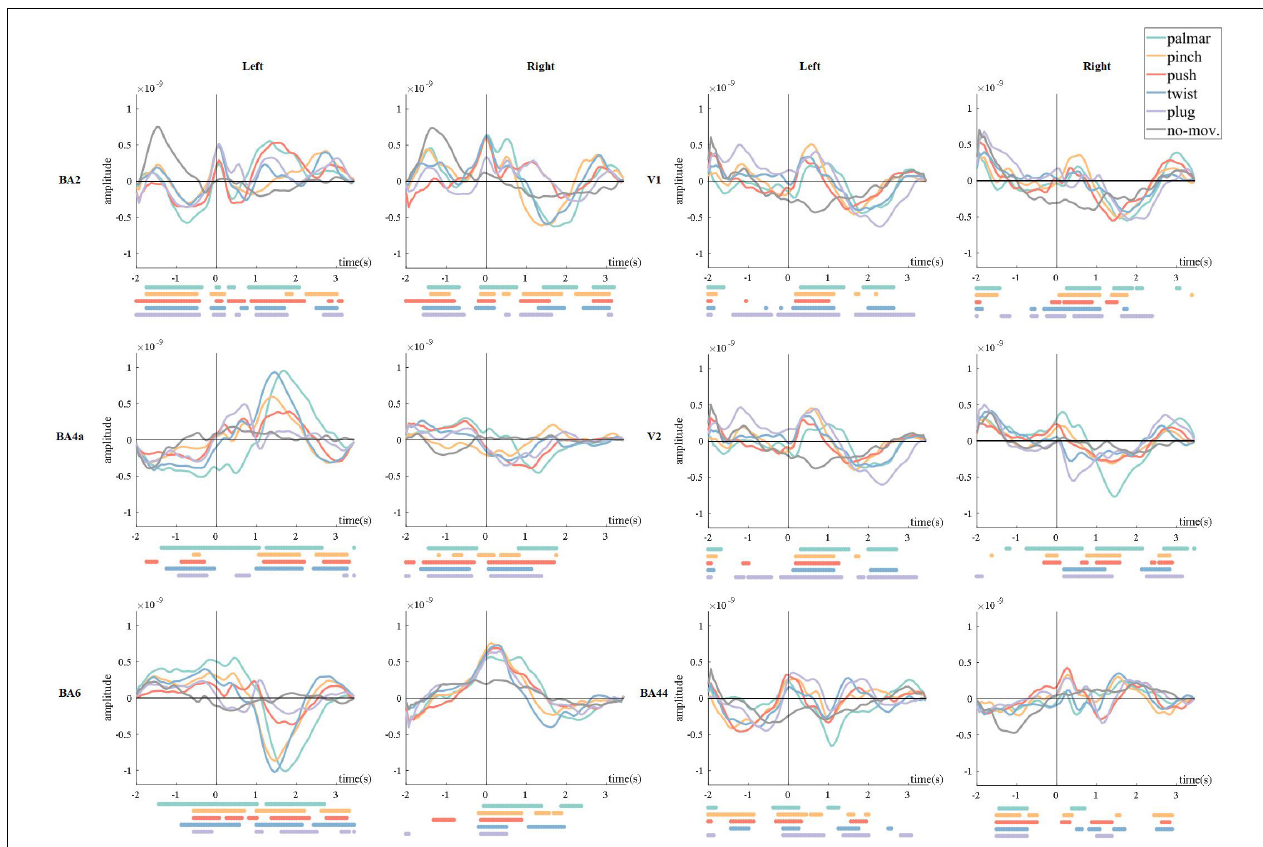
FIGURE 4 | Grand average of all trials of sMRCPs for all conditions. The 0 s corresponds to the movement onset. The dots below each figure were significantly different ( p < 0.05, Wilcoxon rank sum test) time points between every reach-and-grasp movement and the